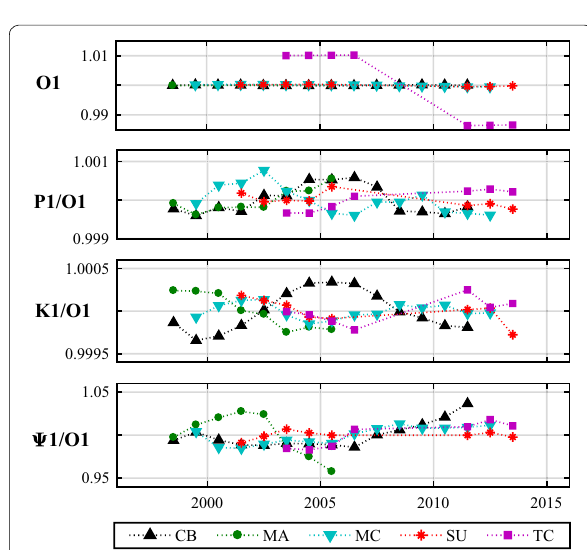
Fig. 8 Amplitude factor of diurnal waves in the second station class. Amplitude factors of P1, K1 and ψ1 waves are normalized by the one of the O1 waves. All amplitude factors are then divided by their mean value for the convenience of